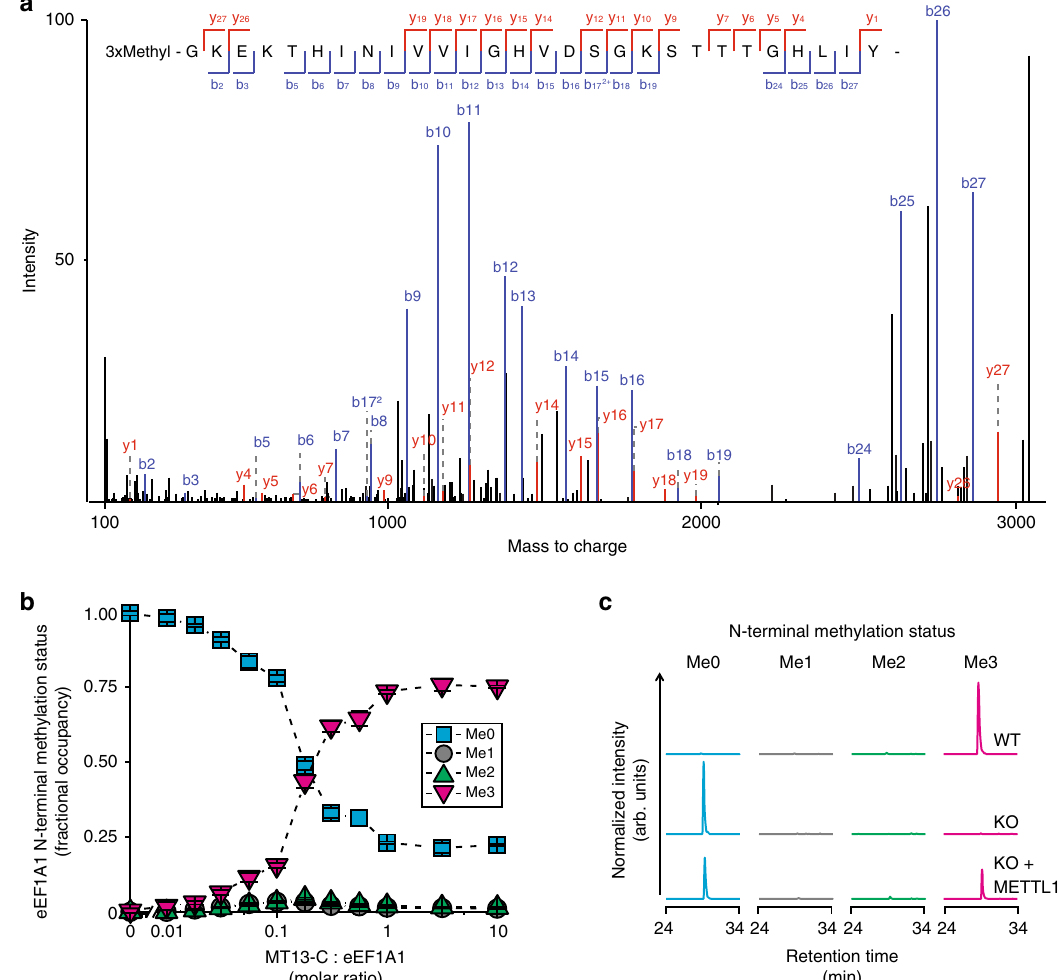
Fig. 2 MT13-C catalyzes N-terminal methylation of eEF1A. a MS/MS spectrum for N-terminally trimethylated peptide encompassing Gly2-Tyr29 from eEF1A treated with MT13-C. b Methylation status of the eEF1A1 N terminus (un-, mono-, di-, and trimethylated; Me0 (cyan squares), Me1 (gray circles), Me2 (green triangles), and Me3 (magenta triangles)) in samples treated with varying amounts of MT13-C. Error bars represent s.d., n = 3. c LC-MS-based extracted ion chromatograms representing the different methylated forms of the eEF1A N terminus in HAP-1 wild type (WT), HAP-1 METTL13 knockout (KO), and KO cells complemented with FLAG-tagged METTL13 (KO +